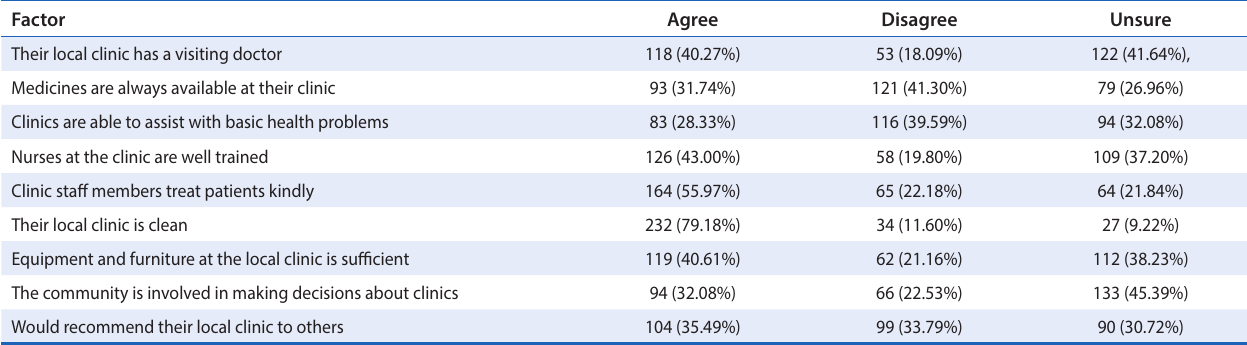
Table 3. Opinions about local clinics